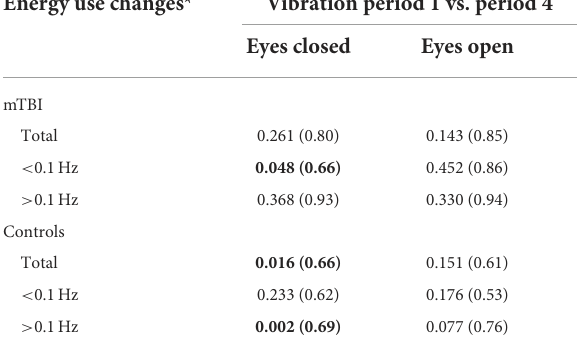
TABLE 4 Energy use changes between vibration period 1 and vibration period 4.